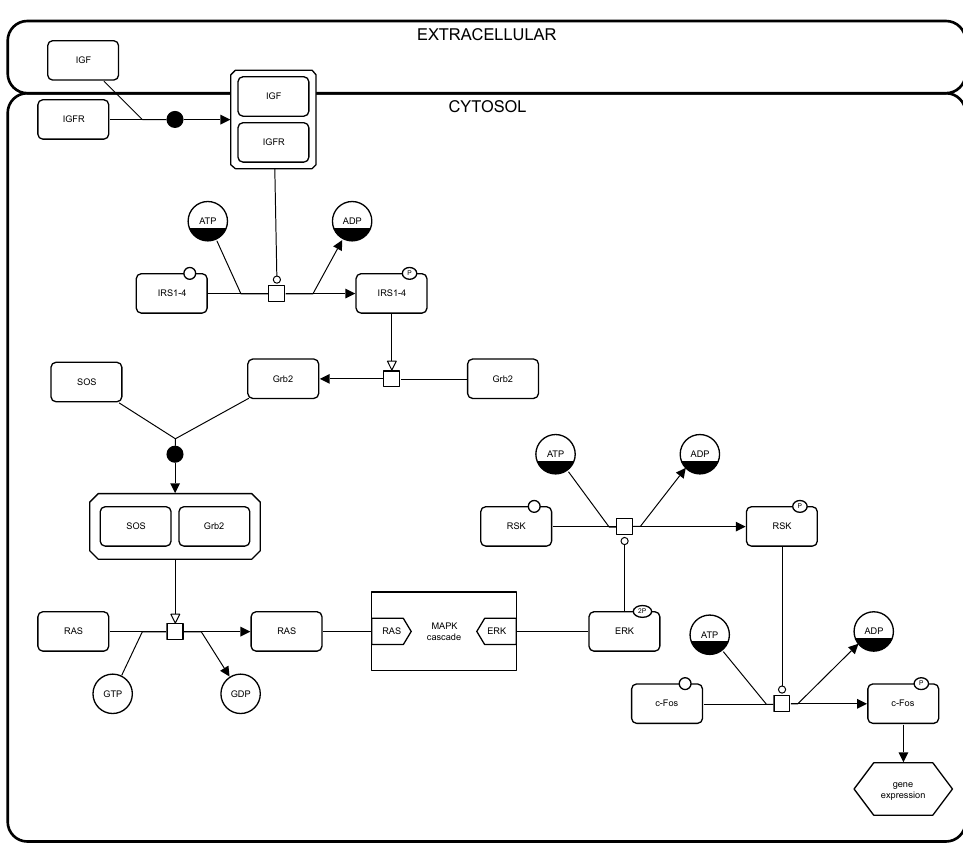
Figure A.2: Insulin-like Growth Factor (IGF) signalling. This example shows the use of compartments and how details can be hidden by using a submap. The submap is shown on Figure A.3 on the next